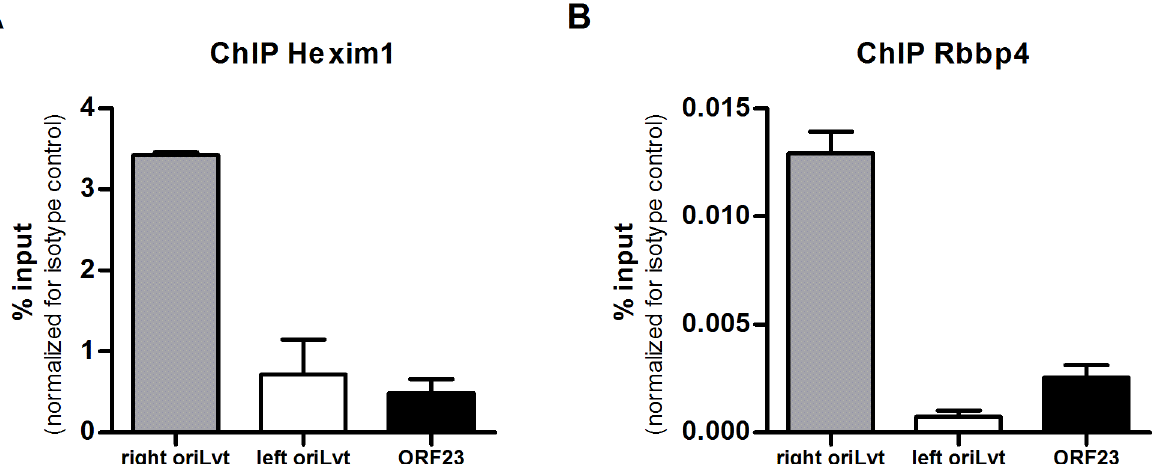
Fig 5. Confirmation of results from DNA-affinity purification and MassSpec. Formaldehyde cross-linking ChIP assays were performed to ensure that Hexim1 and Rbbp4 are associated with DNA of the right oriLyt of MHV-68. The immunoprecipitates isolated from TCMK-1 cells by a specific antibody against Hexim1 (A) or from NIH 3T3 cells by a specific antibody against Rbbp4 (B) were analyzed by quantitative PCR with primer pairs designed to amplify a part of the DNA sequence of the right oriLyt and the left oriLyt, respectively, or by a primer pair amplifying a non-relevant sequence located in the viral ORF23.